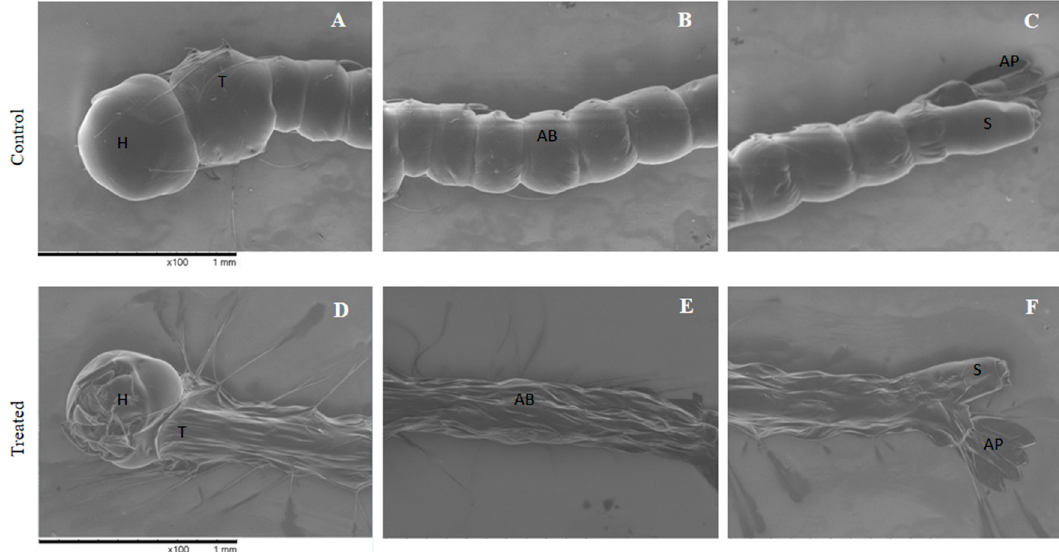
Figure 3. A. aegypti larvae morphology by SEM. Control ( A – C ) showing no alteration on head (H), thorax (T), abdomen segments (AB), siphon (S) and anal papillae (AP). Larvae treated with nanoemulsion containing D -limonene at 250 ppm ( D – F ) showing alterations on head (H), siphon (S) and on cuticles of abdomen (AB) and thorax